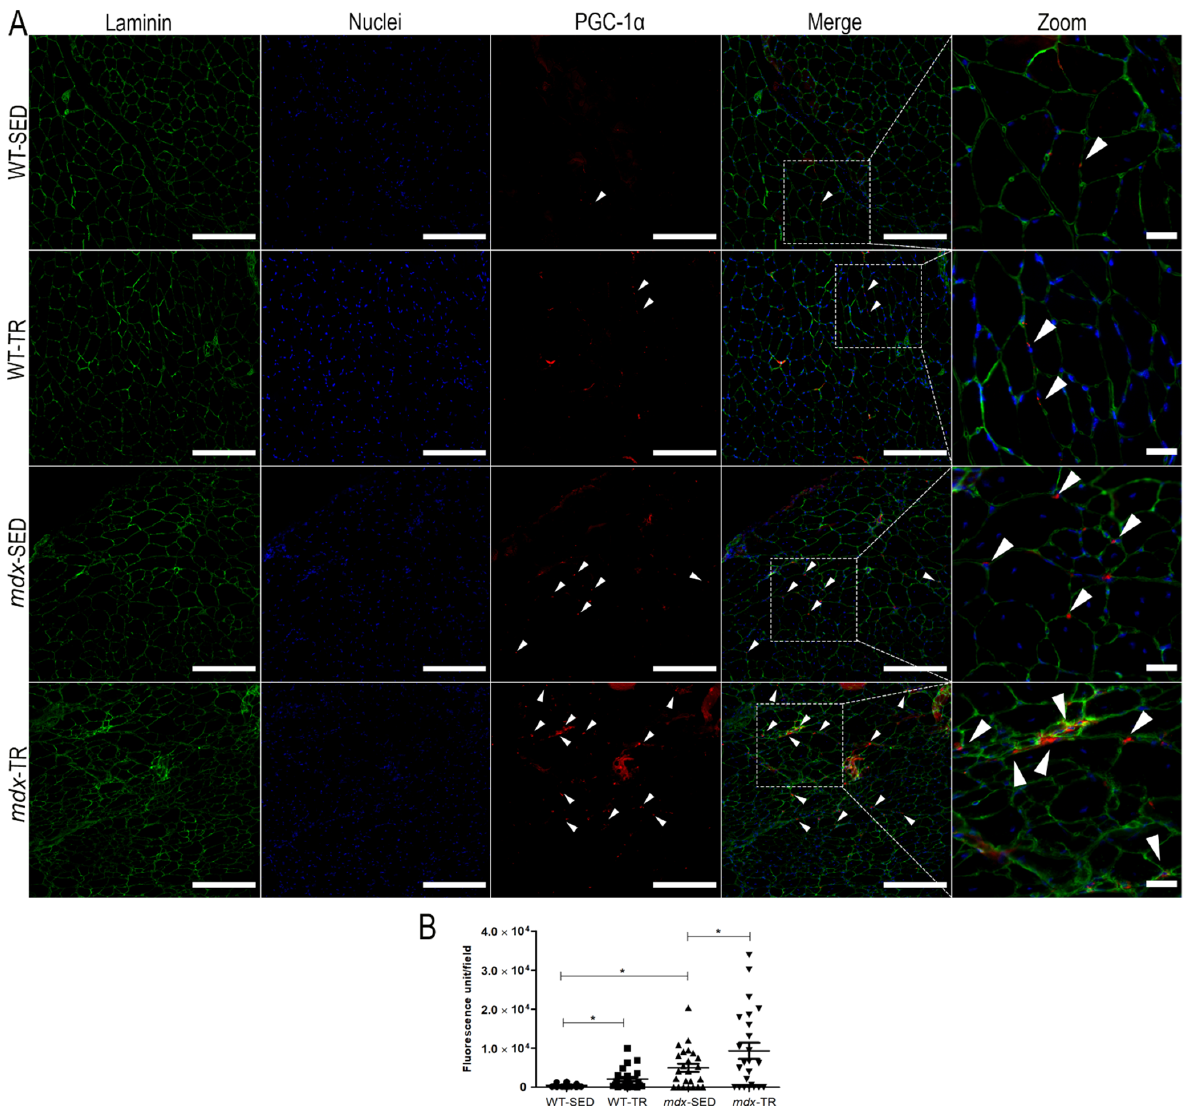
Figure 5. PGC-1 α content is increased in dystrophic muscles. ( A ) Representative images of immunostaining of PGC-1 α . Laminin (red, Cy5), nuclei (blue, DAPI), and PGC-1 α (green, FITC) are shown. White arrows: Indication of PGC-1 α . Images were obtained with the ImageXpress XLS System microscope at 20× magnification. Scale bar = 100 µm. All zoomed areas provided better visual- ization of the PGC-1 α (scale bar = 30 µm). ( B ) mdx -SED group showed higher expression of PGC-1 α when compared to the WT-SED group. After low-intensity training (37 sessions), the WT-TR and mdx -TR groups showed increased expression of PGC-1 α when compared to the sedentary animals. * p < 0.05. Round symbol: WT-SED; Square symbol: WT-TR; Triangle symbol: mdx- SED; Inverted triangle symbol: mdx -TR. Abbreviations: WT-SED: sedentary wildtype; WT-TR: trained wildtype; mdx -SED: sedentary mdx ; mdx -TR: trained mdx . PGC-1 α : Peroxisome proliferator-activated receptor- gamma coactivator (PGC)-1 α protein. 2.4. A Long Period of Low-Intensity Aerobic Exercise Increases the Trophism of Fibers in mdx Mice Fiber diameter analyses showed a significant reduction in the trophism of FTIIA, FTIID, and FTIIB fibers of the psoas muscle of the mdx -SED group when compared to the animals in the WT-SED group (WT-SED × mdx -SED, p < 0.05) (Table 2). However, after 37 training sessions, it was possible to observe an increase in FTIIB and FTIID diameters in